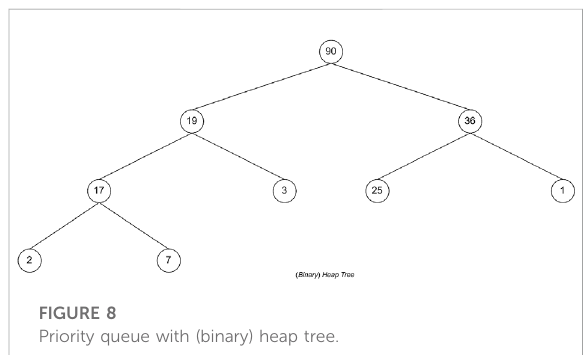
FIGURE 8 Priority queue with (binary) heap